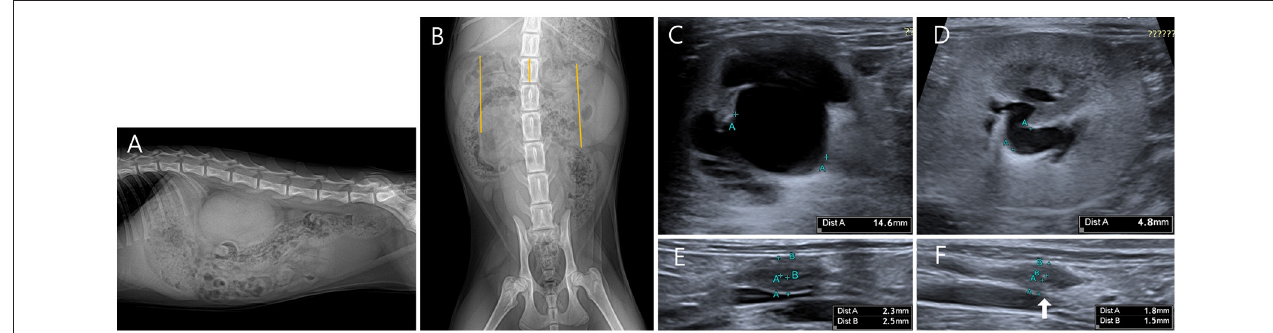
FIGURE 1 | Radiographic and ultrasonography (US) images of the bilateral hydronephrosis in a cat with bilateral ureteral anomalies. (A) It is observed that both kidneys overlap below the second to fourth lumbar vertebrae in the right lateral view. (B) When the length of the second lumbar vertebra was compared with the bilateral height measured by line in ventrodorsal view, the right kidney (5.51cm) was measured to be 3.3 times the L2 length (1.53cm), and the left kidney (5.05cm) was measured to be 3.6 times the L2 length (1.53cm). (C) A transverse US image shows pyelectasis of the right kidney. The height of the right renal pelvis was measured to be 14.6mm. (D) A transverse US image shows the pyelectasis of the left kidney. The height of the left renal pelvis was measured to be 4.8mm. (E) Focal polypoid mural thickening was observed in the middle of the right ureter. Focally thickened ureteral wall can be seen in circumferential form, and the thickness of the ureteral wall was measured to be 2.3mm for the dorsal part and 2.5mm for the ventral part. (F) Focal polypoid mural thickening was observed in the middle of the left ureter. Focally thickened ureteral wall can be seen in circumferential form, and the thickness of the ureteral wall was measured to be 1.5mm for the dorsal part and 1.8mm for the ventral part.